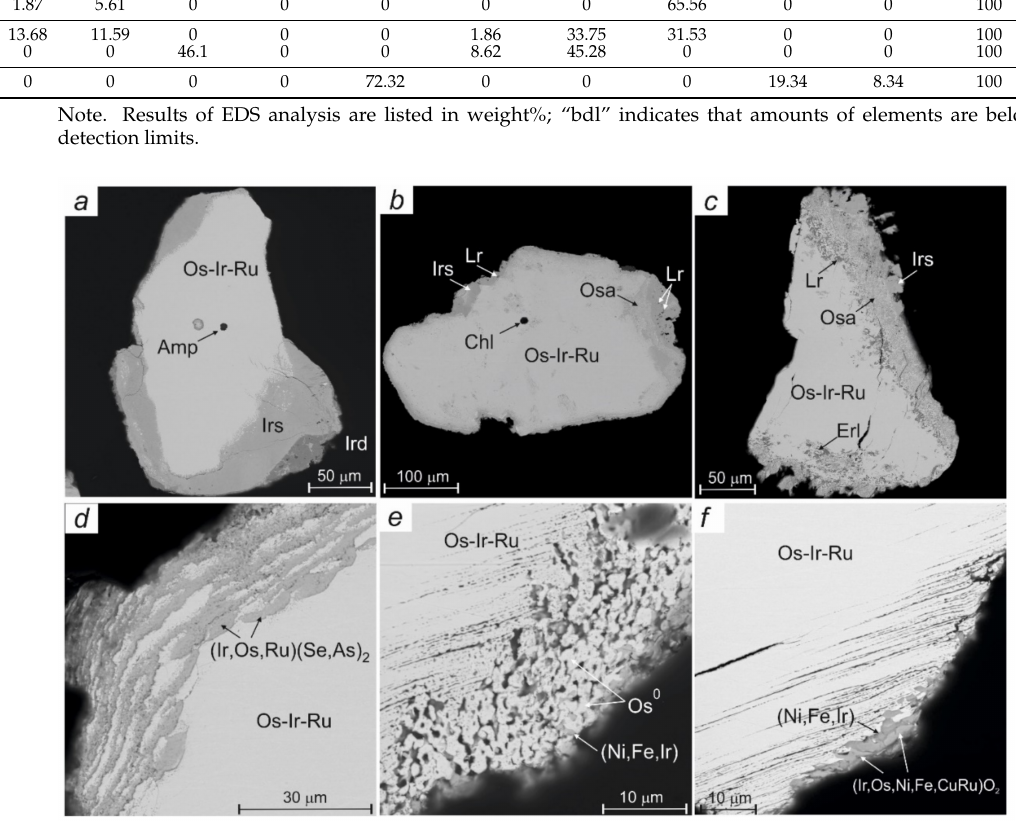
Figure 7. BSE images showing the rim around the grains of Os-Ir-Ru alloys, first type of rim: ( a ) wide rim of replacing Irarsite (Irs) and Iridarsenite (Ird); ( b ) complex rim of osarsite (Osa) and Irarsite (Irs) with laurite (Lr) inclusions; ( c ) rim sequentially folded from ehrlichmanite (Erl) and laurite (Lr), osarsite (Osa) and irarsite (Irs); second type of rim: ( d ) rhythmic-zonal rim of arseno-selenide; ( e ) micrometric grains of native osmium in a garutiite rim; ( f ) PGE oxide in intergrowth with garutiite in a thin